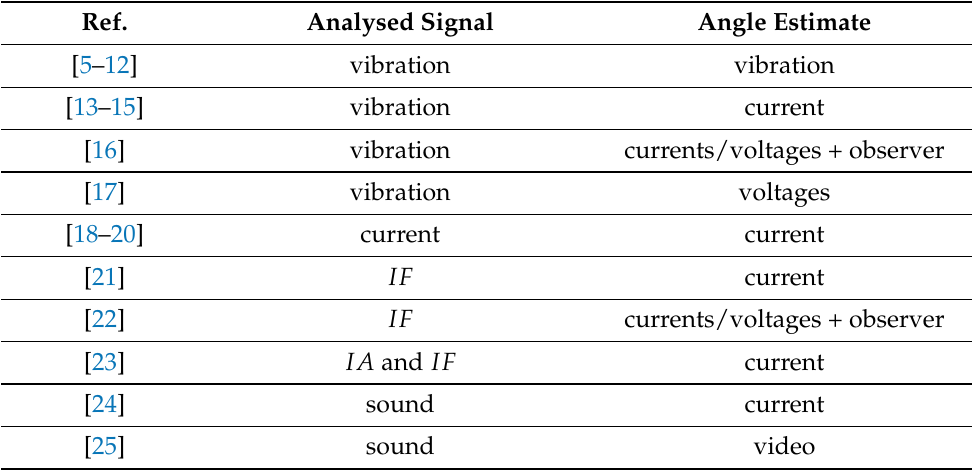
Table 1. Tacholess Order Tracking (TOT) and applications.